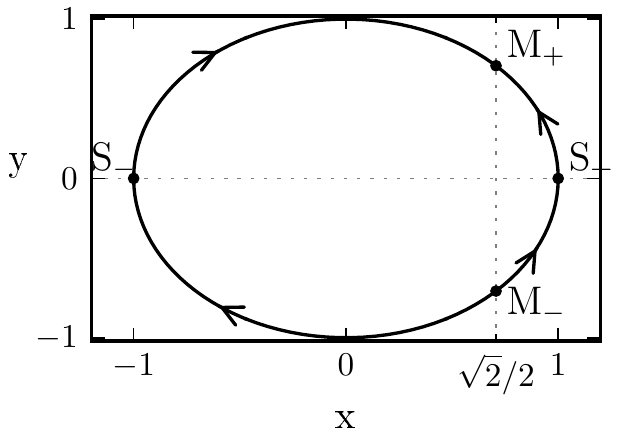
Figure 4. Phase space for the planar system defined by (114) and (115). The critical points are indicated by M for a dust-type effective equation of state, and S ± state. Note that the region y < 0 shows the contracting solutions, while the y > 0 region presents the expanding solutions. Lower and upper quadrants are not physically connected, because there is a singularity in